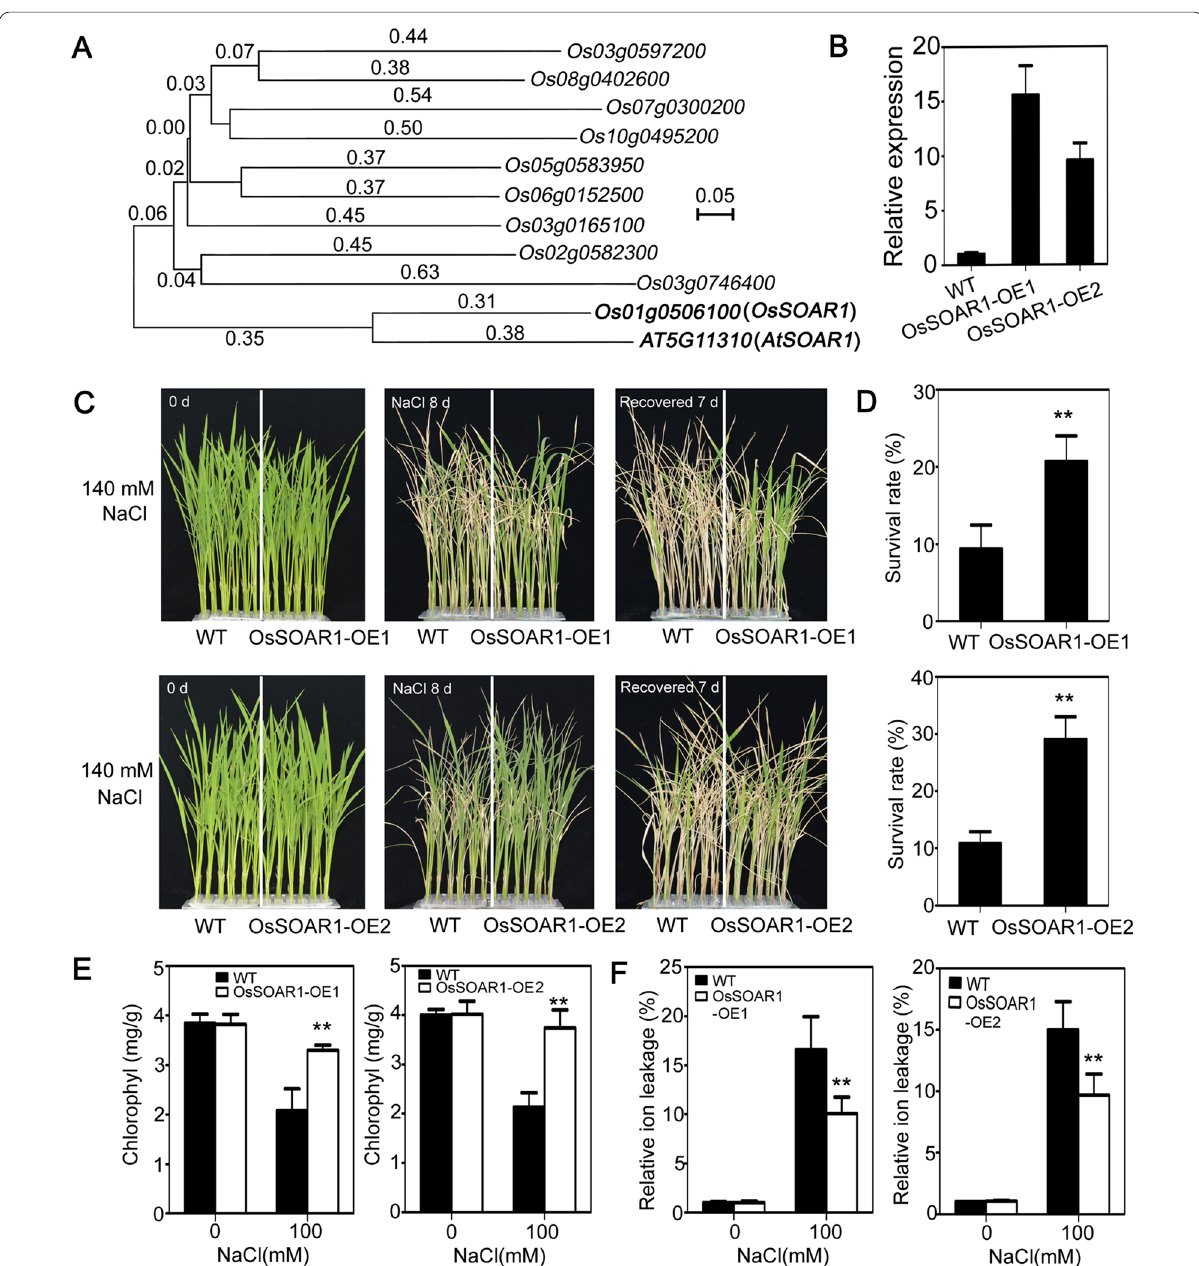
Fig. 6 Performance of OsSOAR1 ‑transgenic plants under salt stress at early seedling stage. A Phylogenic analysis of AtSOAR1 with the homozygous PPR genes in rice using the neighbor‑joining method with MEGA version 11 by alignment of the gene sequences with ClustalW. B Real‑time PCR detection of OsSOAR1 transcripts level in wild‑type and the two transgenic lines OsSOAR1‑OE1 and OsSOAR1‑OE2. Total RNA was extracted from two‑week‑old seedlings and used for cDNA synthesis. Actin1 was used for internal control and the expression level of OsSOAR1 in WT was taken as 1. All the values are means SE from three independent biological determinations. C Phenotypic comparison of wild‑type and OsSOAR1 ‑transgenic ± plants OsSOAR1‑OE1 and OsSOAR1‑OE2 grown under 140 mM NaCl solution at the seedling stage. Hydroponic cultured two‑week‑old seedlings were treated with 140 mM NaCl for 8d, and then recovered for 7d. Three independent biological determinations were conducted and similar results were obtained. D Survival rates of the wild‑type and transgenic plants as described in C after 7d recovery. All the values are means SE from three ± independent biological determinations. Student’s t test was used for comparing the survival rate of each overexpression line with those of wild‑type plants (with significant differences at ** P < 0.01). E , F Chlorophyll content E and relative ion leakage F of the wild‑type and transgenic plants under normal and salt stress conditions. Two‑week‑old seedlings were treated with 100 mM NaCl for 9 d to assay chlorophyll content, or for 24 h to detect relative ion leakage. Student’s t test was used for comparing the chlorophyll content or relative ion leakage of each overexpression line with those of wild‑type plants (with significant differences at ** P <